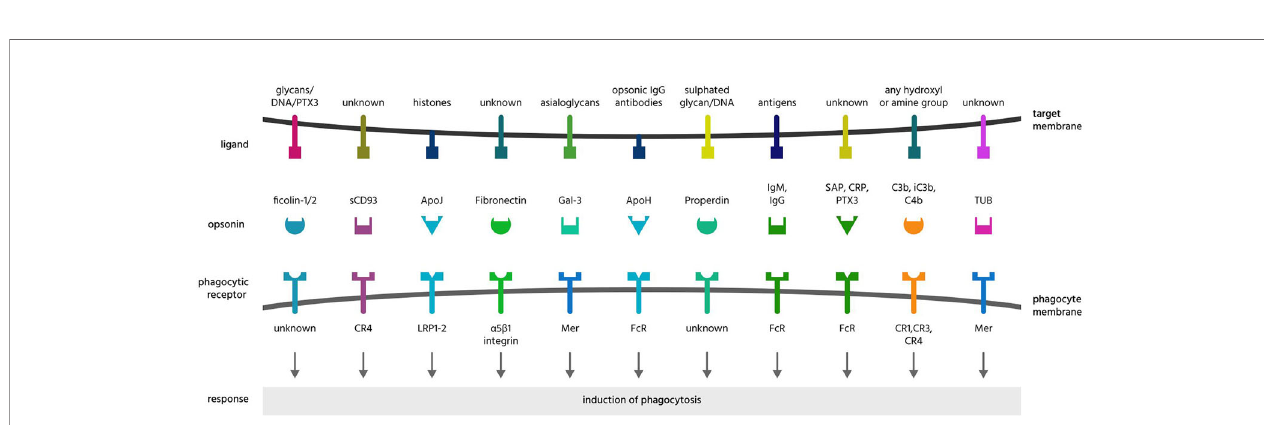
FIGURE 5 | Further opsonins and their ligands and receptors. Apo, apolipoprotein; CR, complement receptor; CRP, C-reactive protein; DNA, deoxyribonucleic acid; Gal-3, galectin-3; Ig, immunoglobulin; LRP, lipoprotein receptor-related protein; PTX3, pentraxin 3; SAP, serum amyloid protein; sCD39, soluble cluster of differentiation 93; TUB,